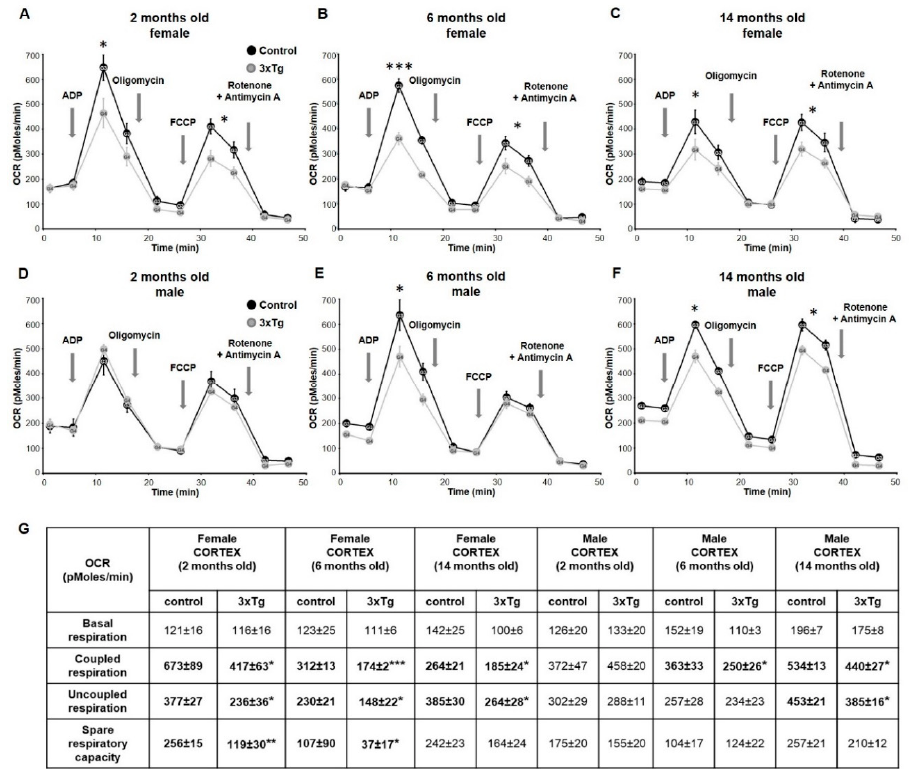
Figure 1. Representative measurements of oxygen consumption rates in mitochondria isolated from the cortex of 3xTg and age-matched control females at 2 months ( A ), 6 months ( B ) and 14 months of age ( C ), and males ( D – F ). Basal level of OCR was measured in the presence of Complex I substrates pyruvate and malate. Coupled respiration was measured after the addition of ADP (2 mM). Oligomycin (1 µ M) was then added to terminate coupled respiration through inhibition of ATP synthase. The uncoupled respiration rate was determined by adding the uncoupling agent FCCP (4 µ M) to remove the pH gradient and enable maximal rates of electron transport. The injection of rotenone (1 µ M) and antimycin A (1 µ M) blocked respiratory electron flux at complexes I and III (non-mitochondrial respiration rates). Calculated coupled respiration at state 3 and uncoupled respiration were significantly decreased (* p < 0.05) in cortical mitochondria of 3xTg female mice at 2, 6 and 14 months, and SRC was significantly reduced at 2 and 6 months (Table G , in bold). In 3xTg males, coupled respiration was significantly decreased at 6 and 14 months, and uncoupled respiration was down at 14 months (* p < 0.05). Data are expressed as OCR in pmoles / min, and values are expressed as mean ± SEM of n = 4–6